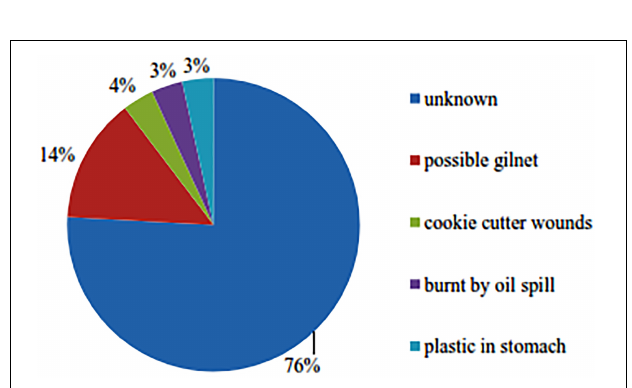
FIGURE 8 | Probable causes of mortality of stranding cases in Balikpapan Bay.